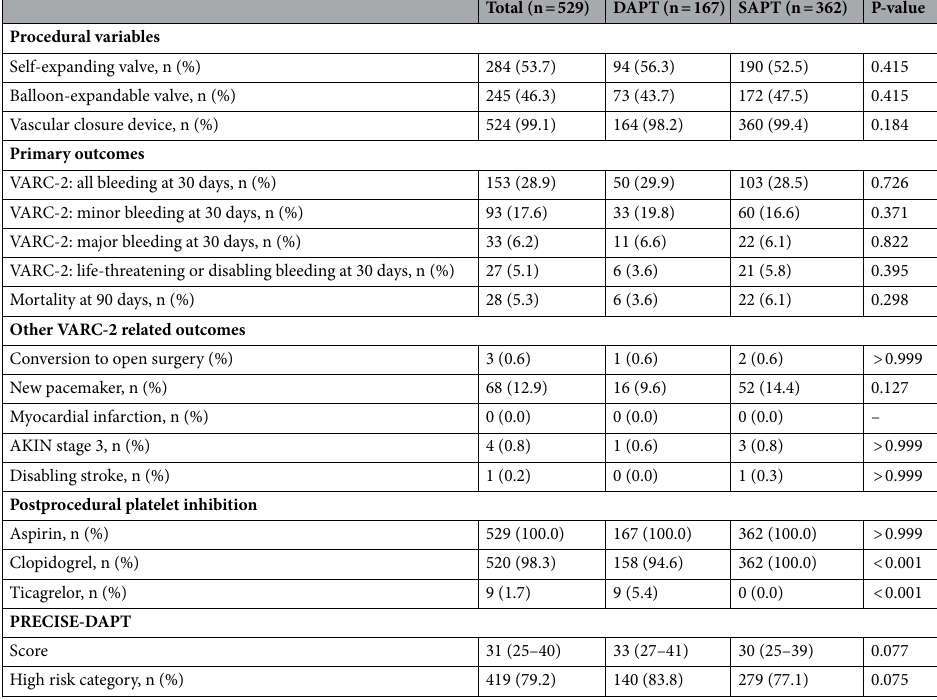
Table 3. Procedural variables and outcomes. Values are presented as counts (percentages) or median (interquartile range). A p-value of < 0.05 was considered statistically significant. AKIN acute kidney injury